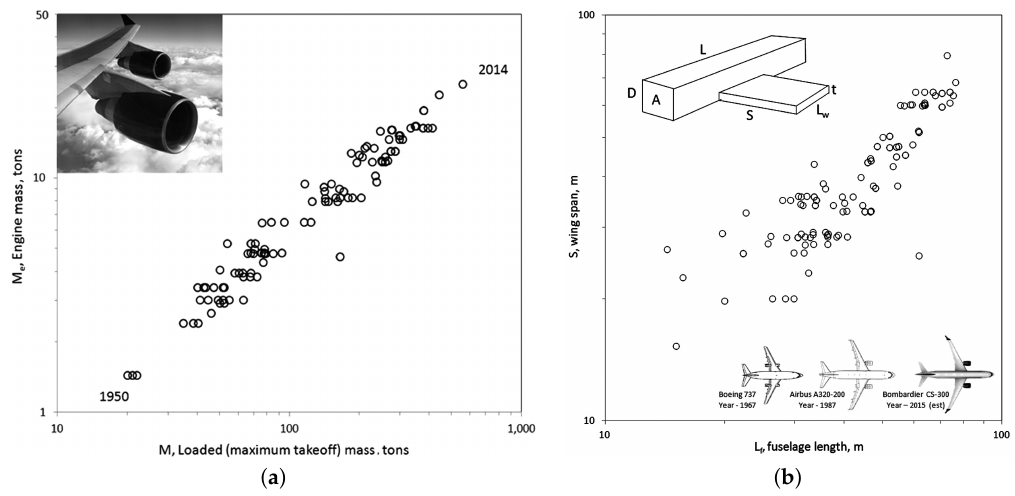
Figure 4. ( a ) Engine size vs. airplane size during the evolution of airplanes; ( b ) Wing span vs. fueslage legth [8]. Reprinted from Bejan, A.; Charles, J.; Lorente, S. The evolution of airplanes. J. Appl. Phys. 2014 , 116 , 044901, with the permission of AIP